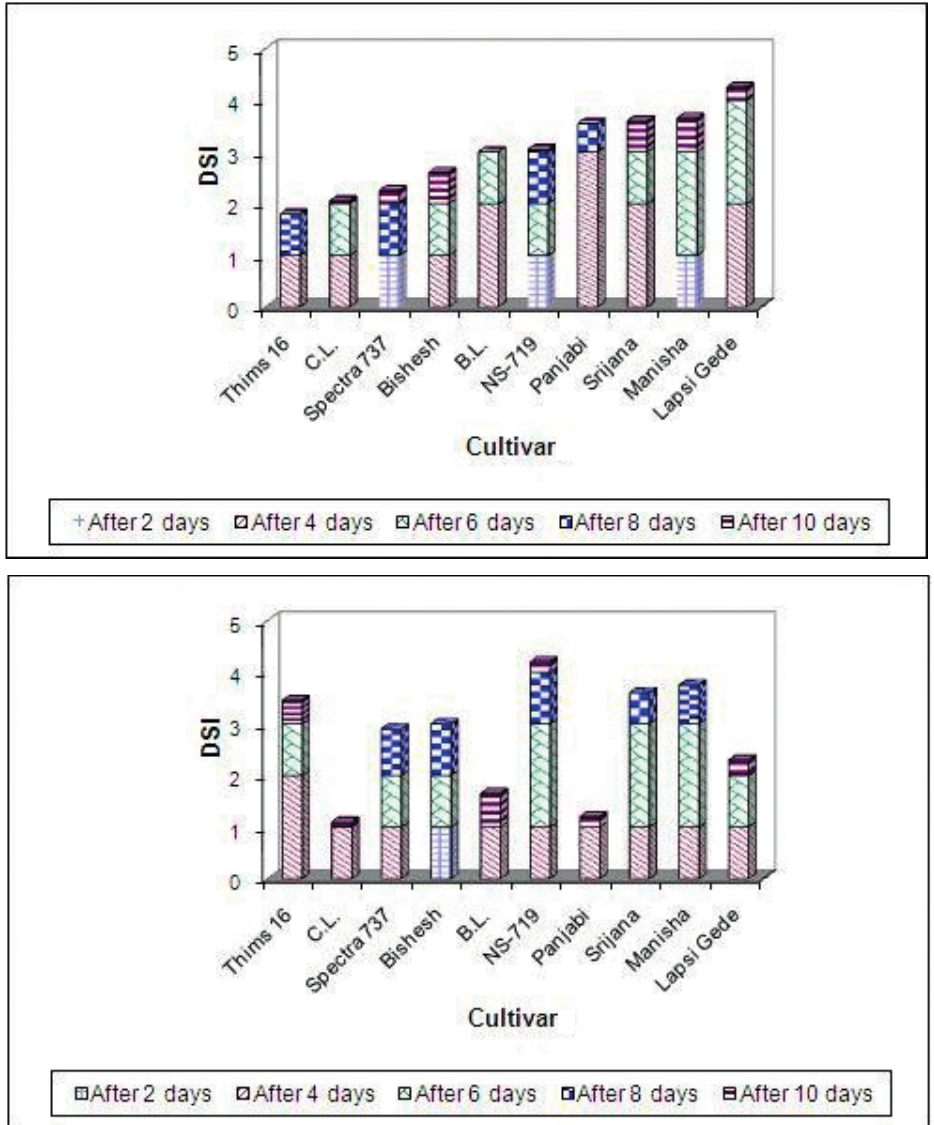
Figure 2. Disease severity index of tomato cultivars 2, 4, 6, 8 and 10 days after inoculation with Pseudomonas syrin- gae pv. tomato (PST 5N07). A, In the field experiment. B, In the tunnel